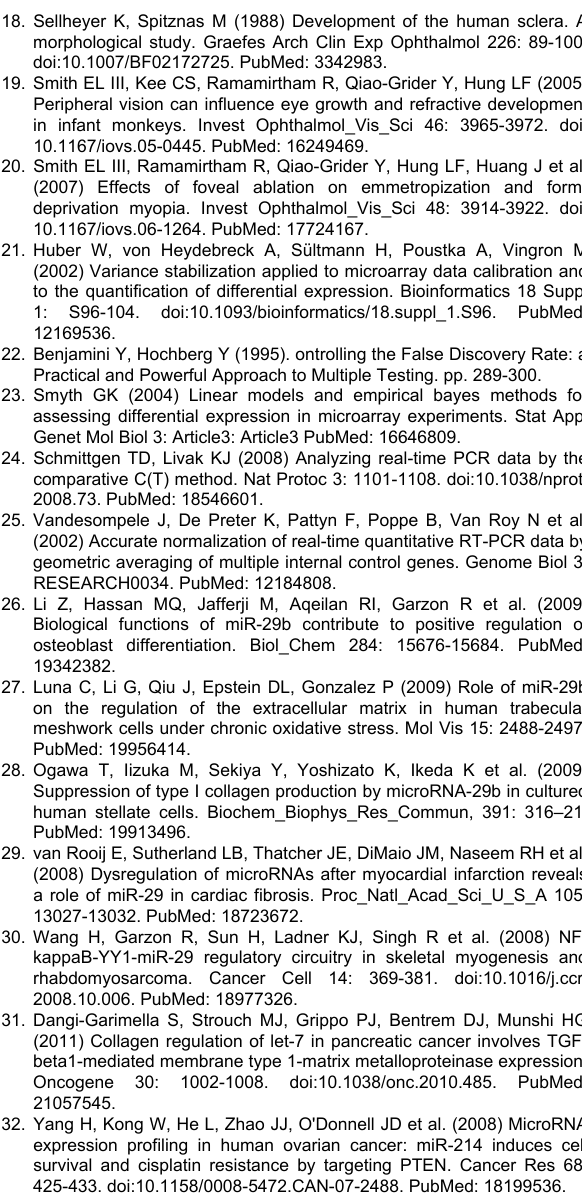
Table S4. Clusters.